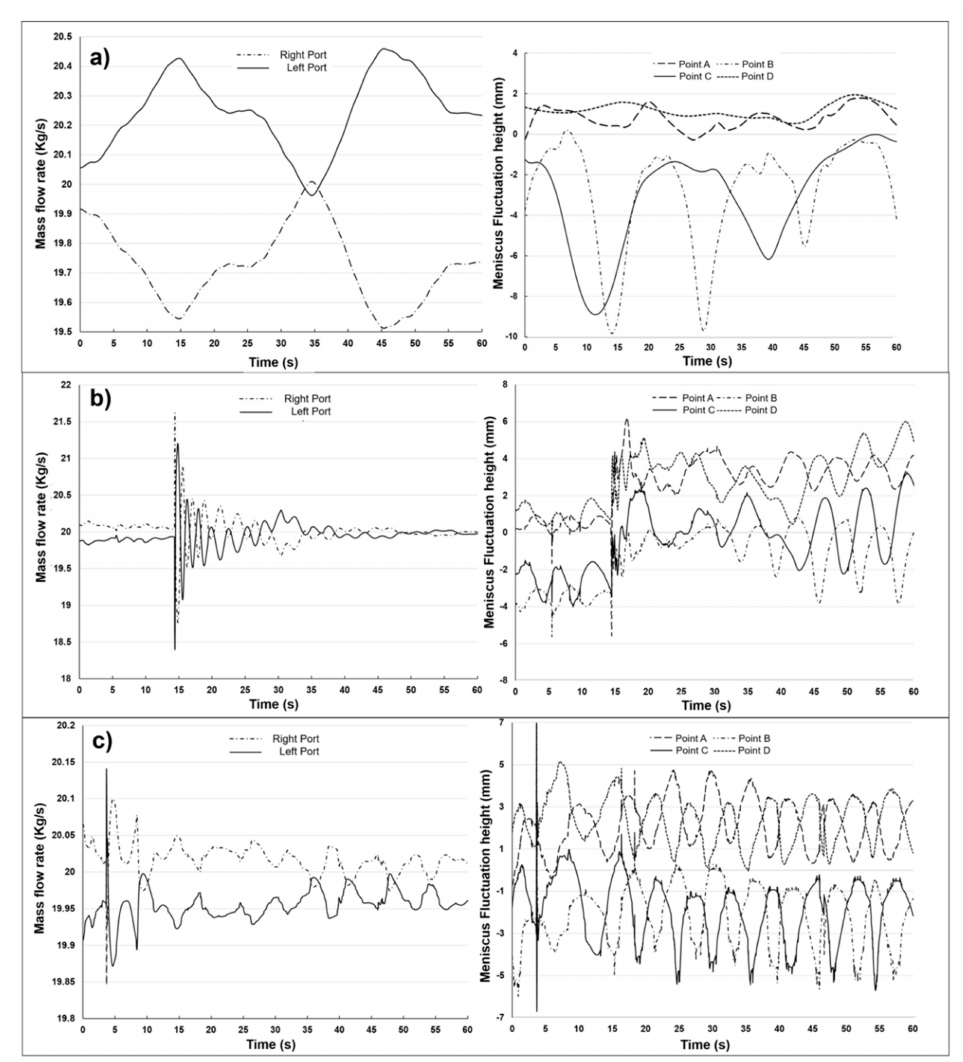
Figure 11. Mass flow rate in the SEN ports and meniscus fluctuation height during 60 seconds at unsteady-state conditions, V-EMBr, ( a ) 0, ( b ) 0.1 and ( c ) 0.2